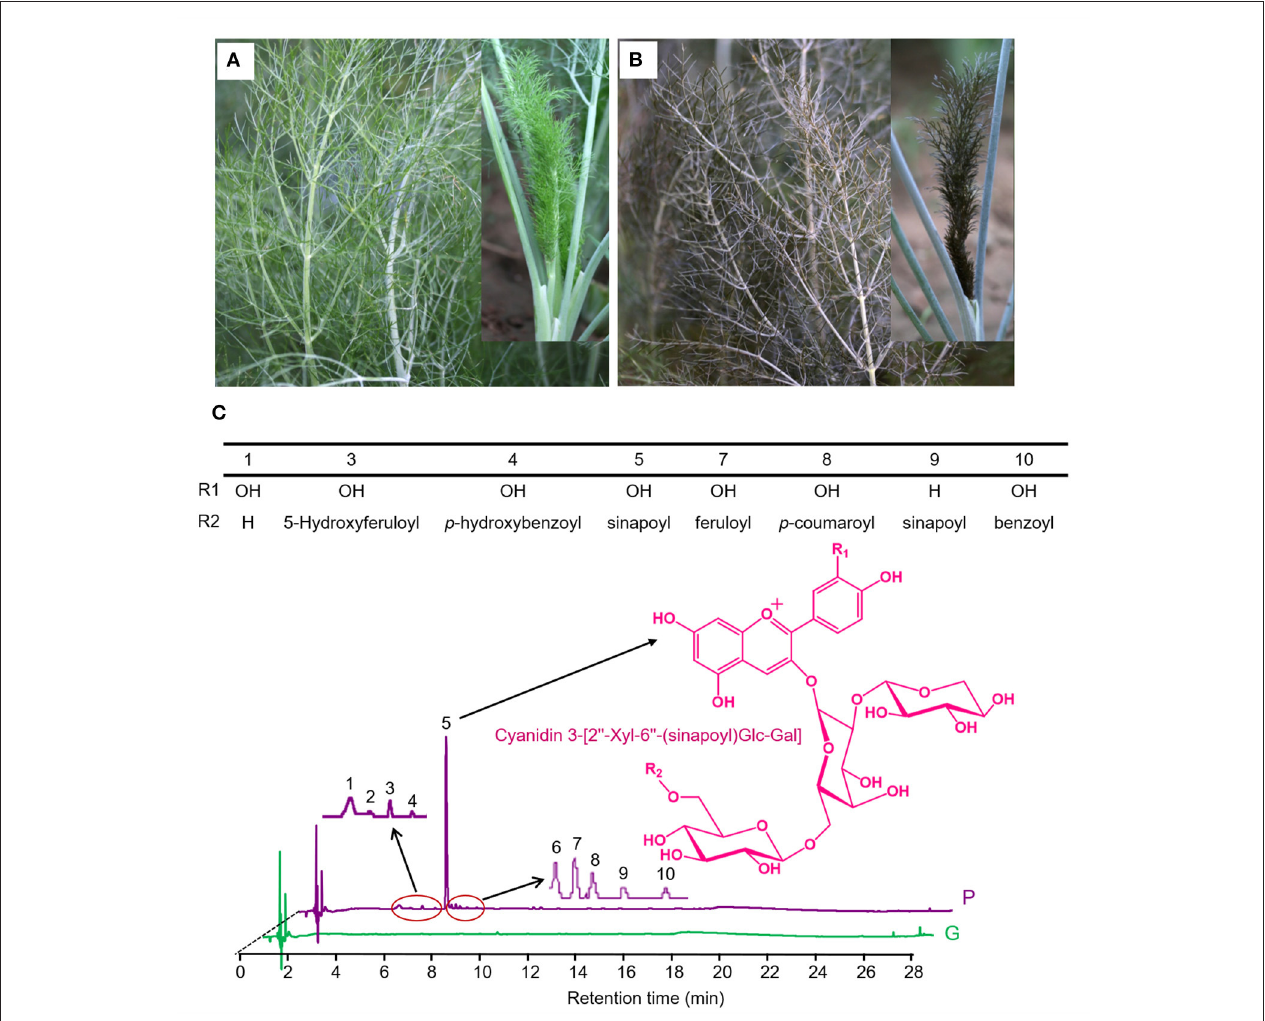
FIGURE 1 | The structures of anthocyanins identified in purple fennel. (A) Phenotypes of the purple variety (Bronze, P) and (B) green variety (Florence, G). (C) The major anthocyanins in purple fennel were depicted as component 1 to 10 in chromatogram. Anthocyanins display a structural homology. The key differentiation is acyl groups (benzoyl, 4-hydroxybenzoyl, p-coumaroyl, caffeoyl, feruloyl, 5-Hydroxyferuloyl, and